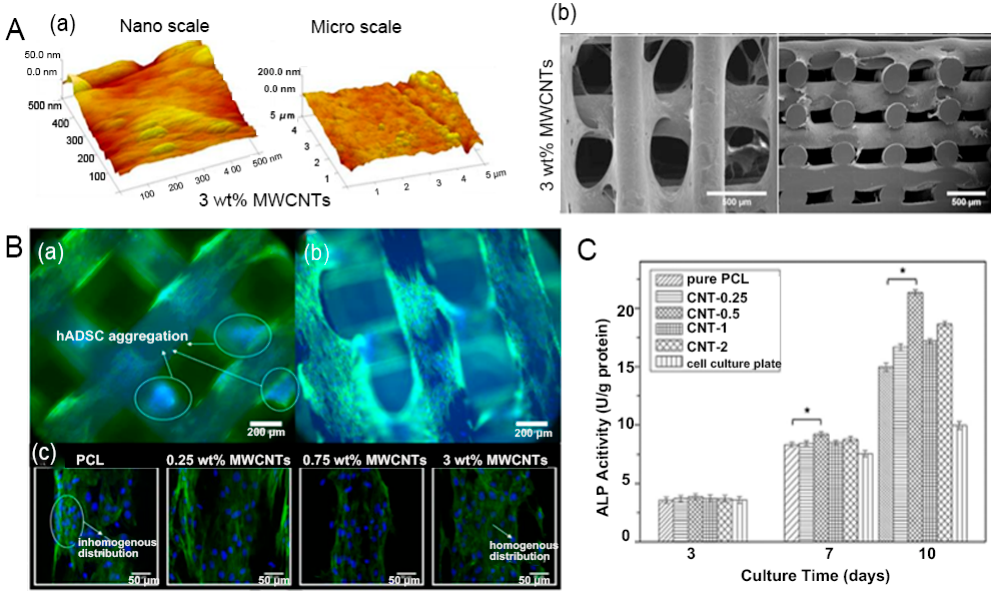
Figure 5. Carbon nanotube- polycaprolactone (PCL–CNT) scaffolds used for bone regeneration ( A ): ( a ) AFM images of the surface topography of the printed PCL–MWCNT scaffolds; ( b ) SEM images of cell morphology at day 14 on the PCL-MWCNT scaffold. ( B ) Fluorescence microscopy images of ( a ) PCL and ( b ) PCL-3 wt.% MWCNTs; and ( c ) confocal images of cell morphology on surfaces of all PCL–MWCNT sca ff olds at 14 day. ( C ) ALP activity of bone marrow stem cells (BMSCs) cultured